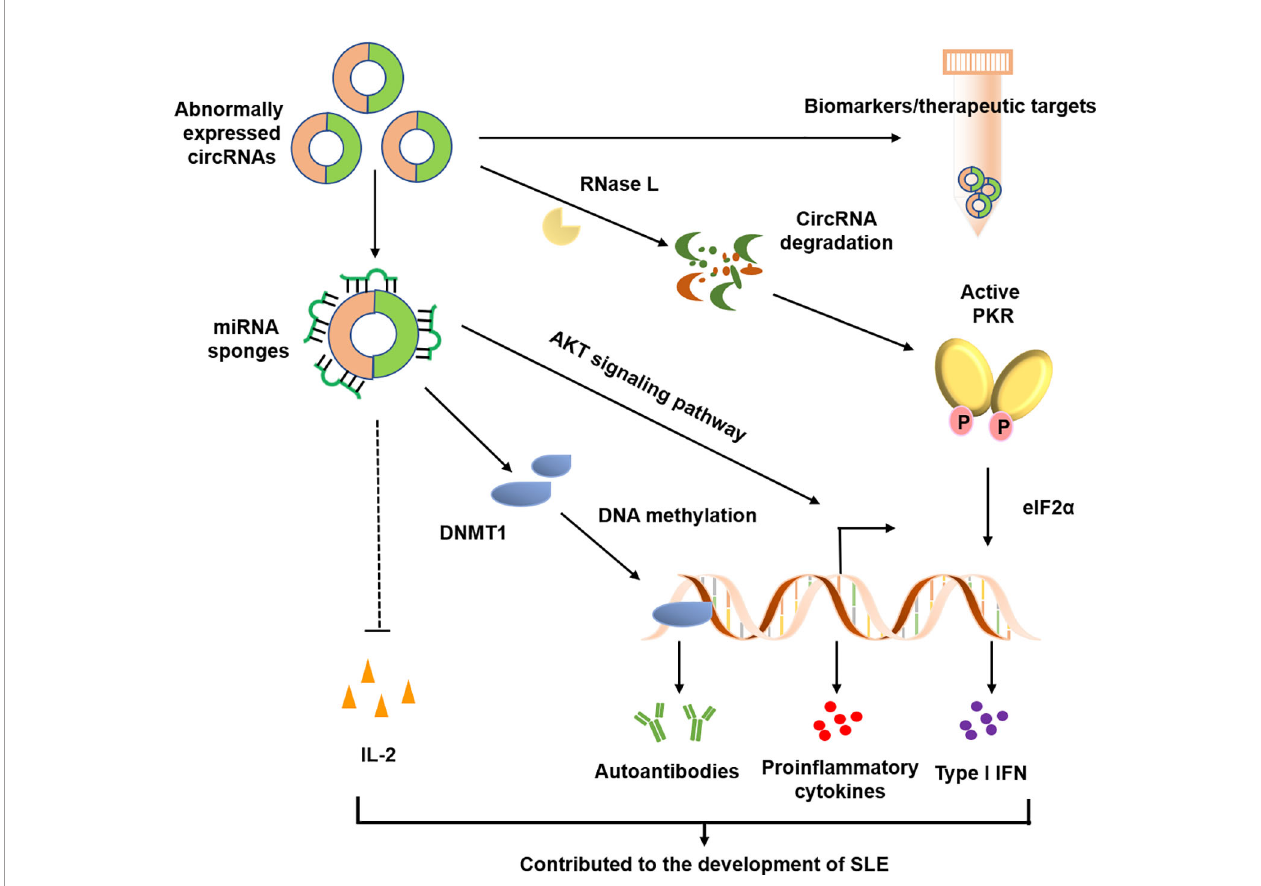
FIGURE 3 | Possible roles of circRNAs in SLE. CircRANs may be involved in the pathogenesis of SLE by regulating various biological processes, such as DNA methylation, activation of AKT signaling pathway, and aberrant PKR activation. Furthermore, circRNAs may serve as biomarkers for the diagnosis and severity of